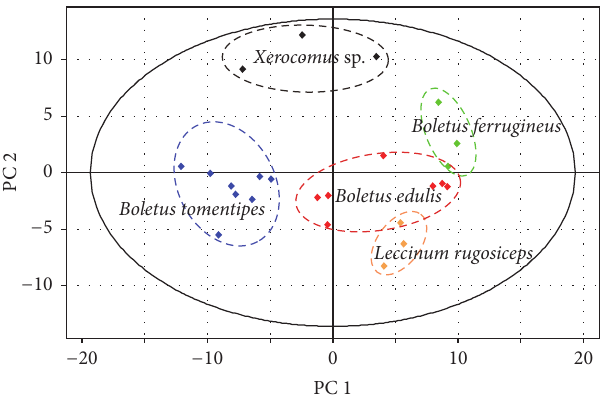
Figure 3: PLS-DA score plot based on UV spectra of five species of wild-grown Boletaceae